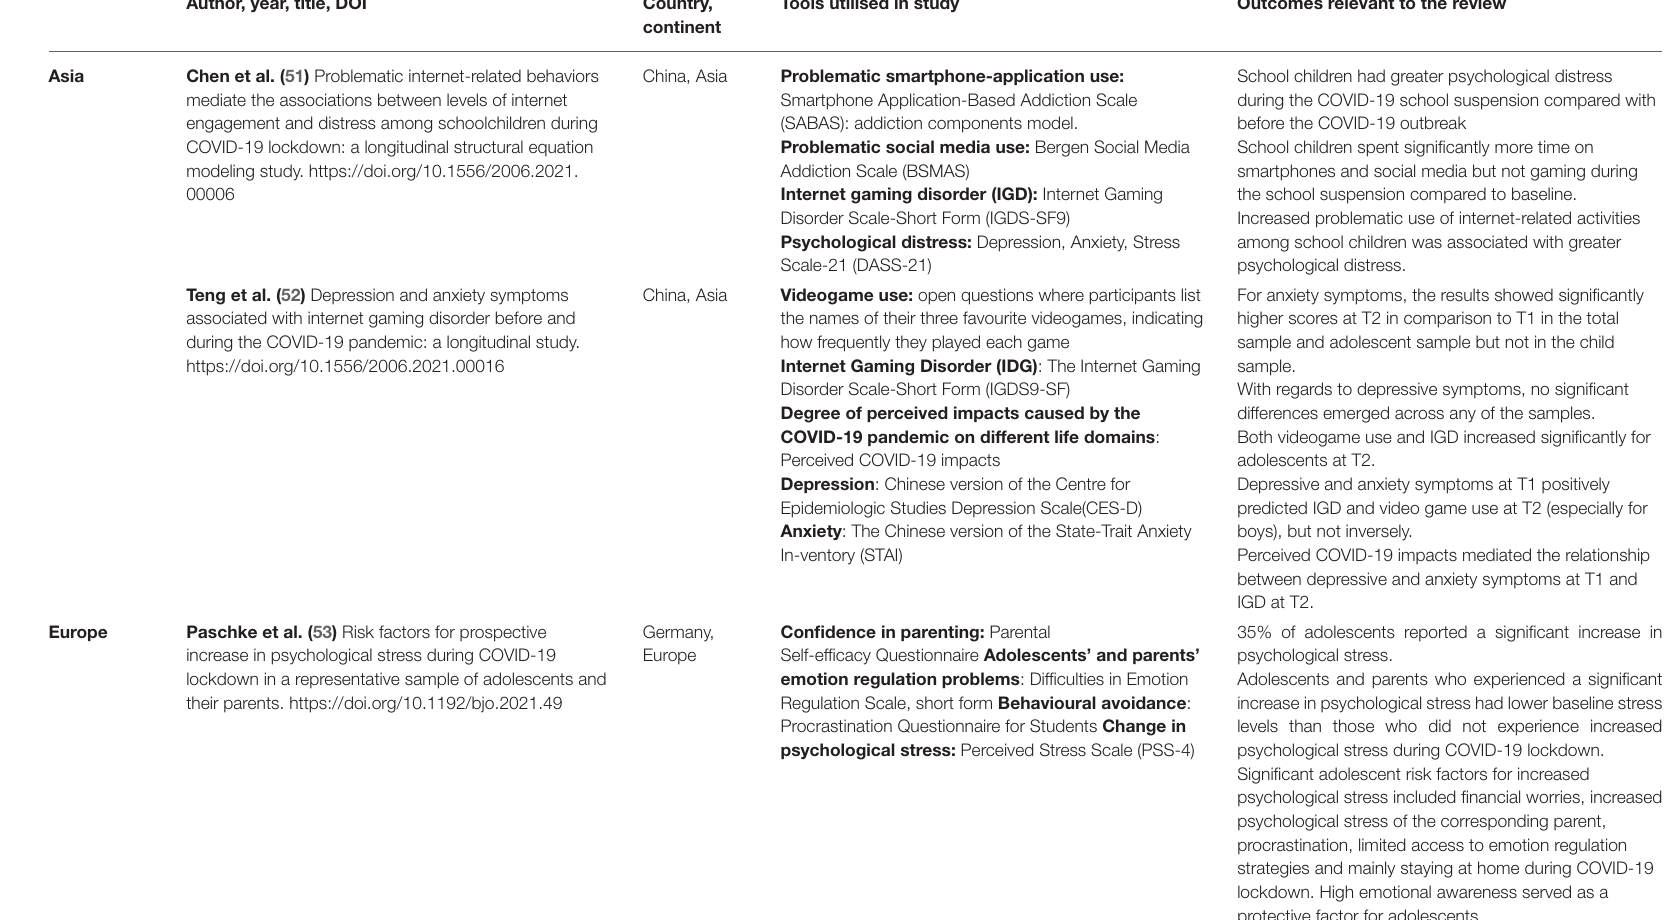
TABLE 3 | Overview of longitudinal studies organised by continent and